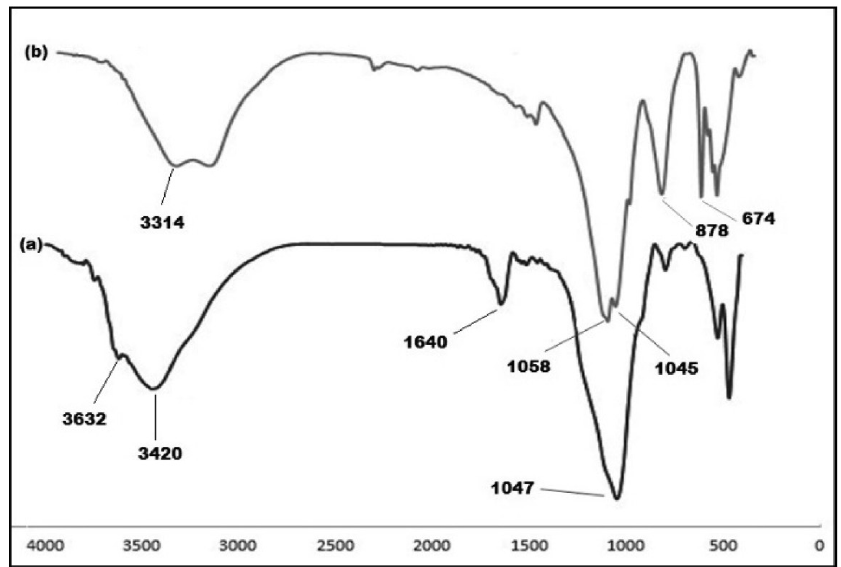
Figure 3. The FT-IR spectrum of MMT and